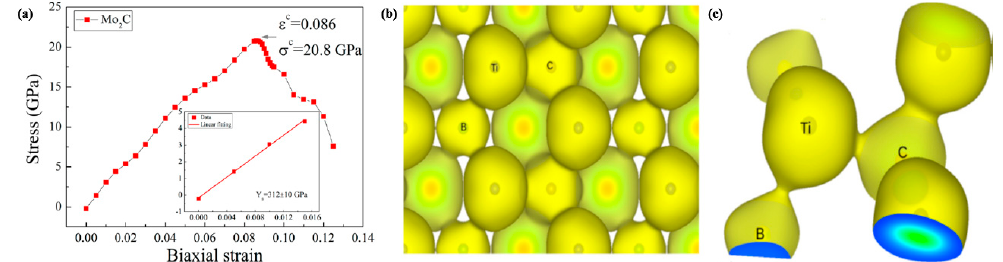
Figure 4. ( a ) Calculated stress versus biaxial strain for the Mo 2 C. Reproduced with permission from [34]. Copyright ACS Publications, 2016. ( b ) Shows the plot in an extended region, ( c ) zoomed view focused on central Ti atom bonded with B and C. The stronger covalency of the Ti-C bond compared to the Ti-B bond is visible. Reproduced with permission from [51]. Copyright AIP Publishing, 2017.